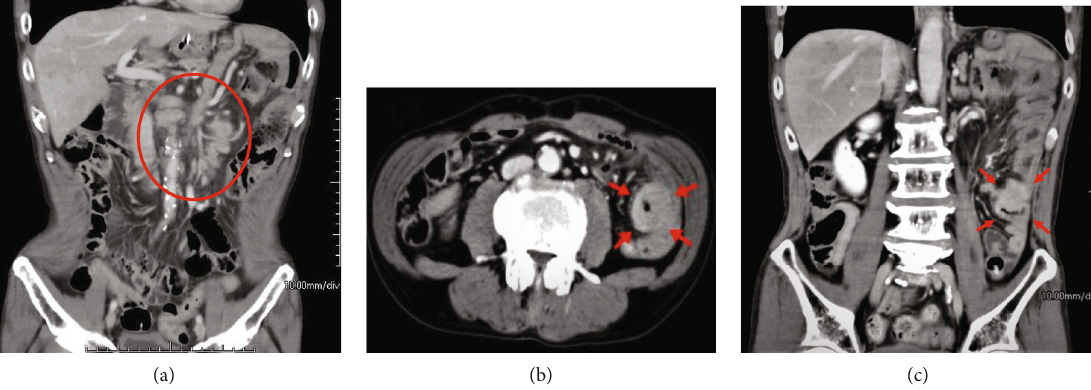
Figure 2: Axial and coronal images of multidetector row CT scan. (a) The preoperative CT scan showed swollen para-aortic and mesenteric lymph nodes. These were diagnosed with lymphatic metastases from the primary esophageal carcinoma. (b, c) CT scans revealed a single occlusive point. The circumferential tumor let us take into consideration an esophageal cancer metastasis as a potential cause of the obstruction. The arrows show a thickened small intestine wall, thus showing the metastatic site.